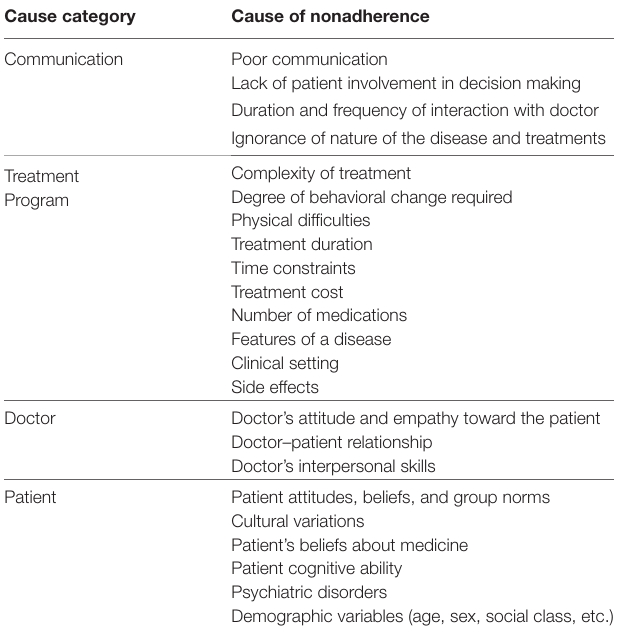
TaBle 1 | Factors associated with nonadherence in human medicine from Jin et al. (3), Martin et al. (4), and Vermeire et al. (5). cause category cause of